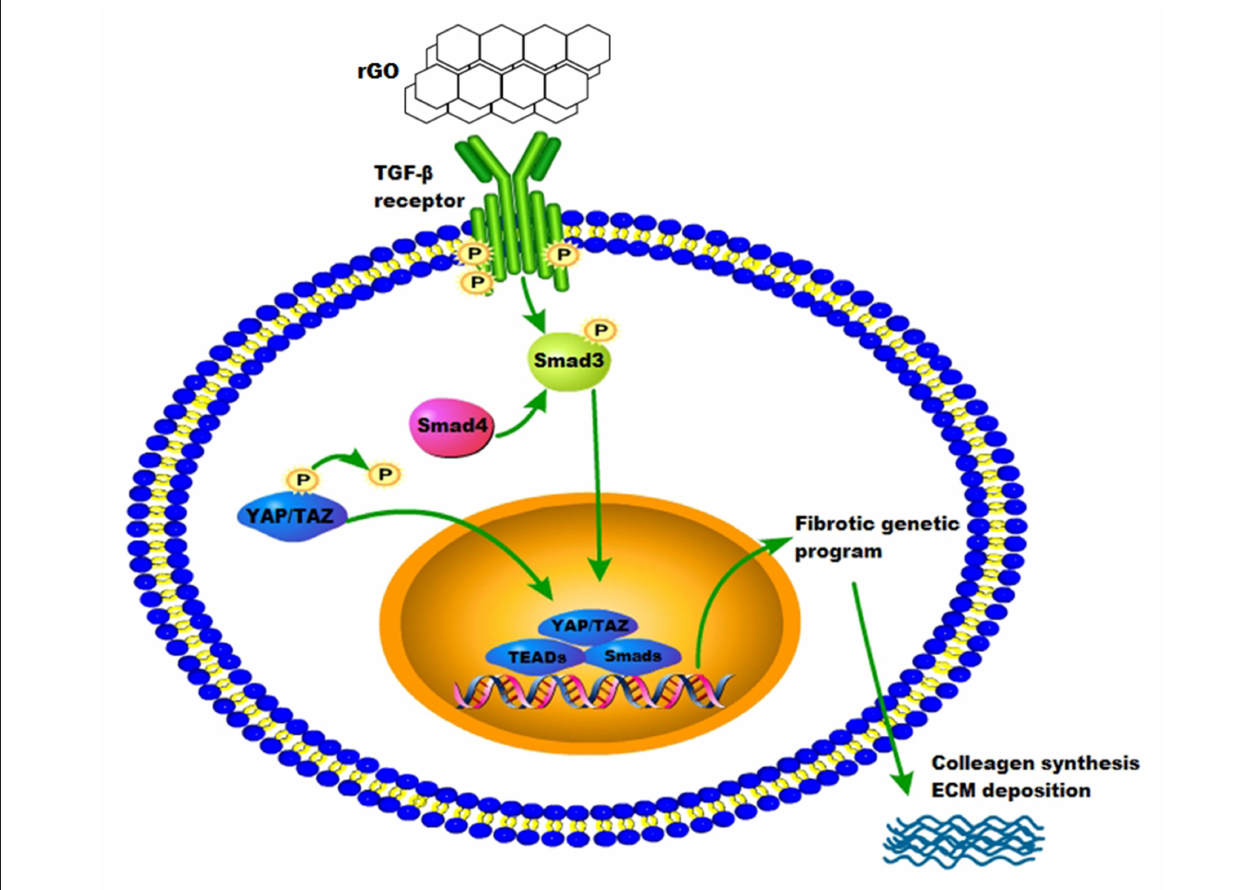
FIGURE 6 | Proposed model of the possible mechanisms of rGO in reducing myocardial